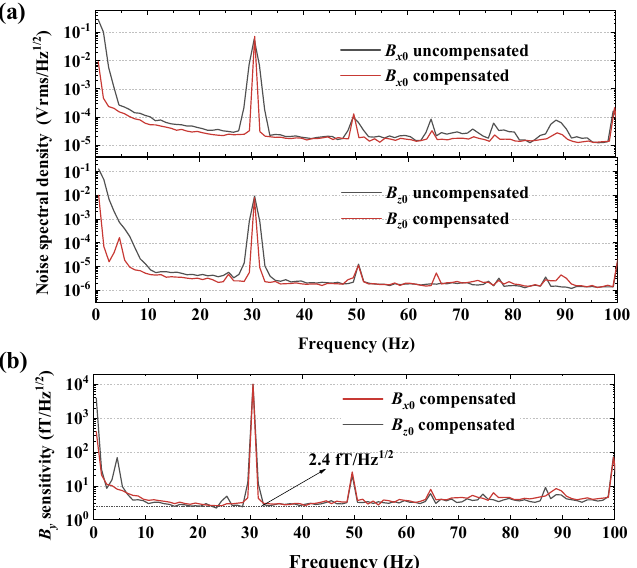
Figure 8. Noise spectral density and sensitivity with applied B y at 30.5 Hz. ( a ) Voltage noise spectral density with background field along the x - and z -axes; ( b ) sensitivity of the magnetometer after